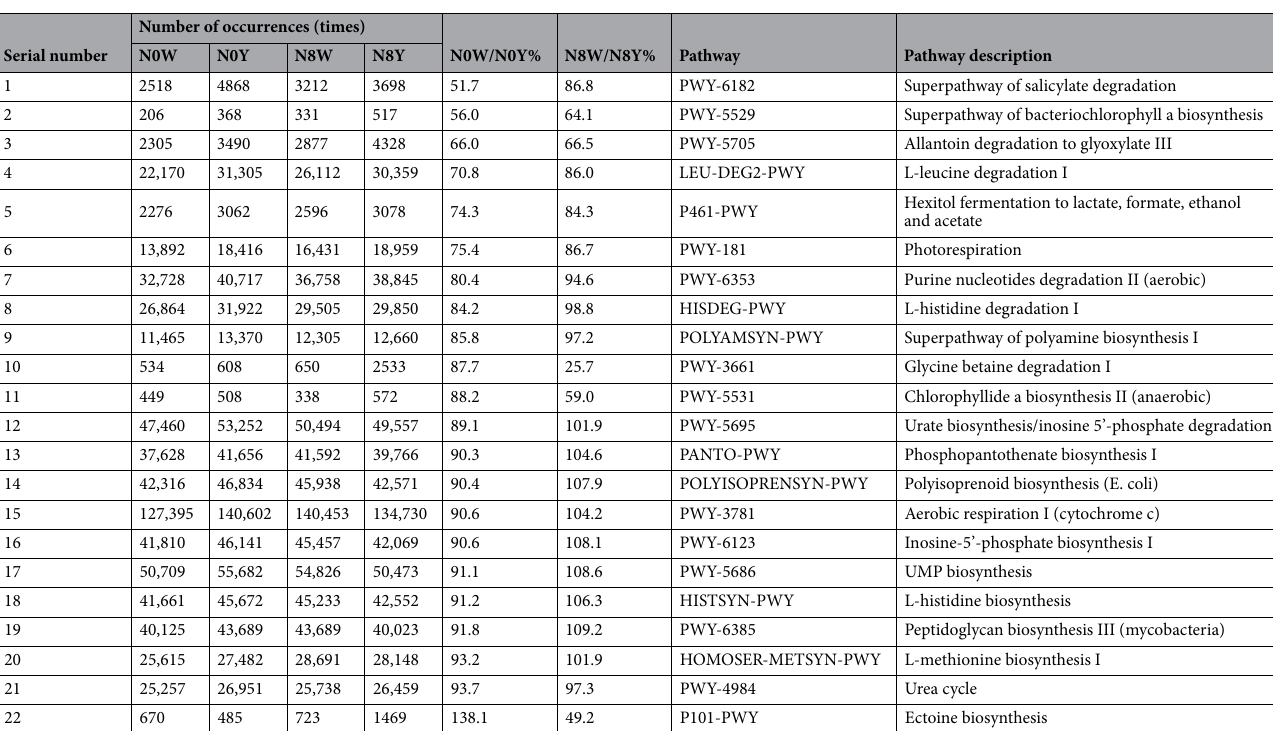
Table 2. Cluster analysis of differential populations of soil microorganisms between sorghum roots under different nitrogen